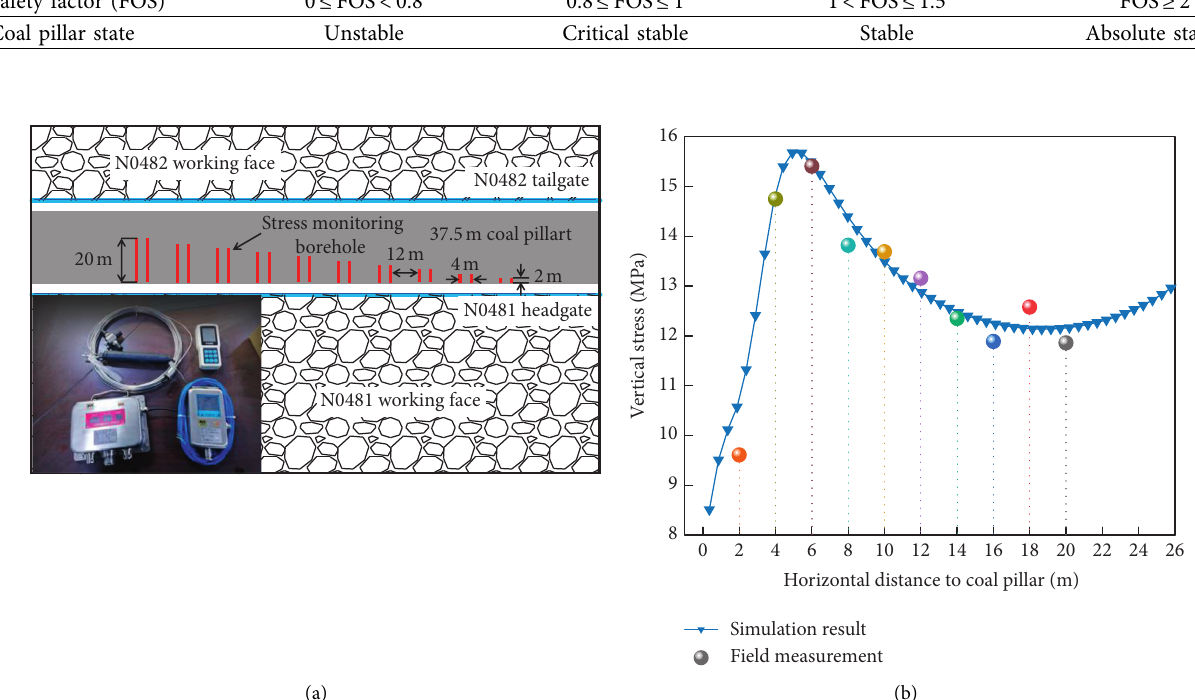
Figure 9: Comparison between field measurement and simulation result. (a) Layout of field measurement. (b) Field measurement and simulation